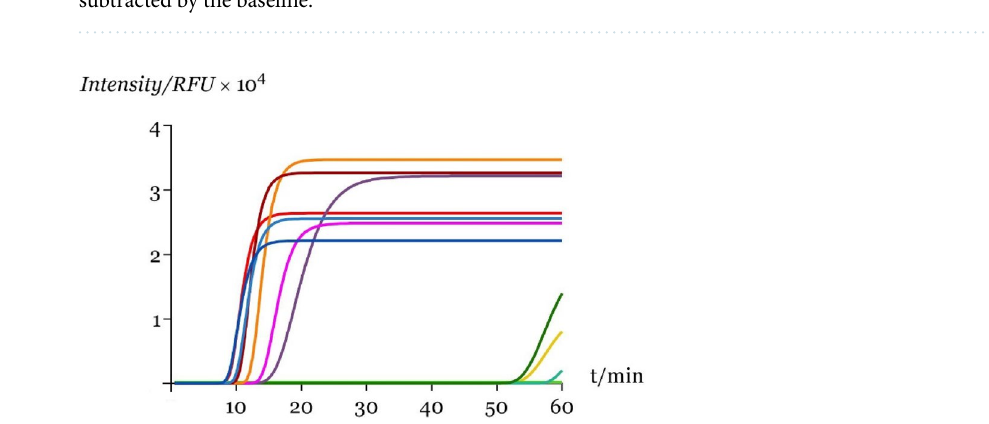
Figure 3. Sensitivity evaluation of the qLAMP method through the analysis of ten-fold serial dilutions (Dil.1 – Dil.10) of pure D. polymorpha DNA with initial concentration of 567.30 ng/µL according to the fittings from Eq. (1) performed using GraphPad Prism version 8.0.0 for Windows, GraphPad Software, San Diego, California USA, www. graph pad. com: (dark blue line) Dil.0, (red line) Dil.1, (light blue line) Dil.2, (deep red line) Dil.3, (orange line) Dil.4, (fucsia line) Dil.5, (purple line) Dil.6, (blue line) Dil.7, (dark green line) Dil.8, (green line) Dil.9, (yellow line) Dil.10.